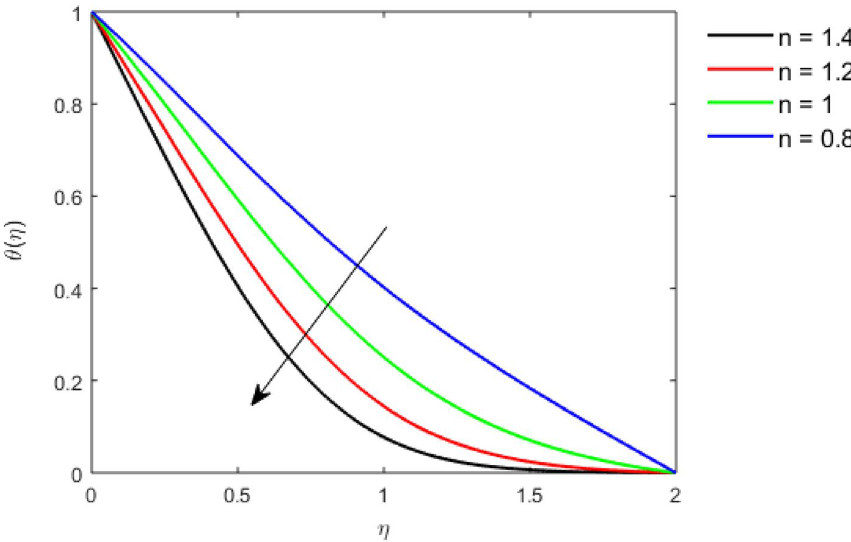
Figure 5. Thermal profile for decreasing power-law fluid index with thickness index m = 0.8, r = 0.6, Pr = 1 of a disk.